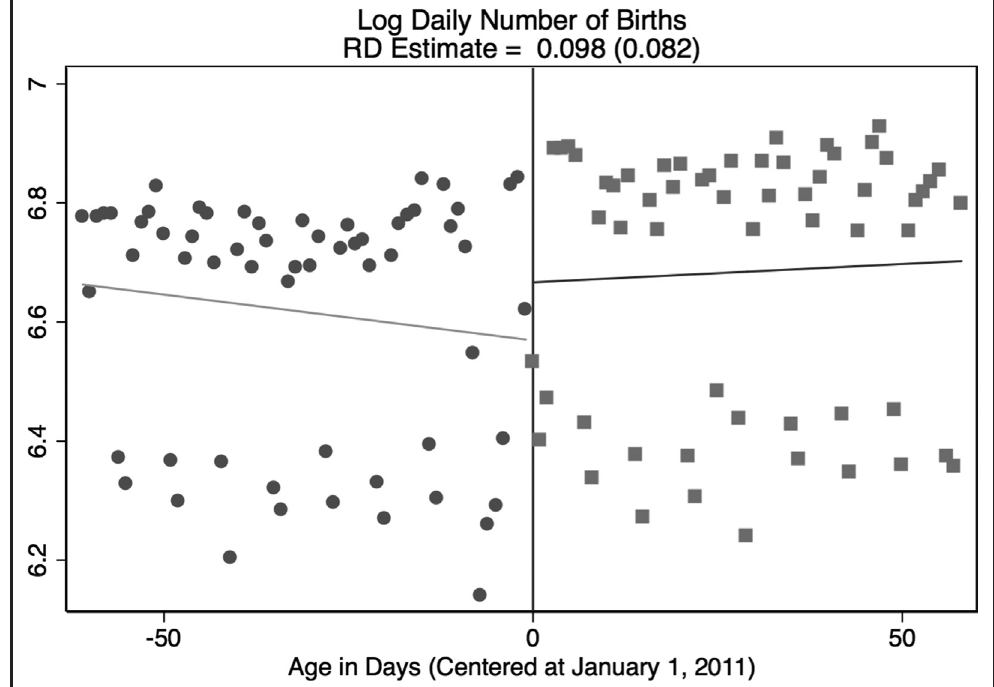
Figure 4 Births discontinuity. Notes : The log of the number of children born to mothers from November 1 2010 to February 28 2011, and separate linear fits on each side of the January 1 2011 cutoff. The vertical line denotes the PPL cutoff of January 1 2011, normalized to 0.